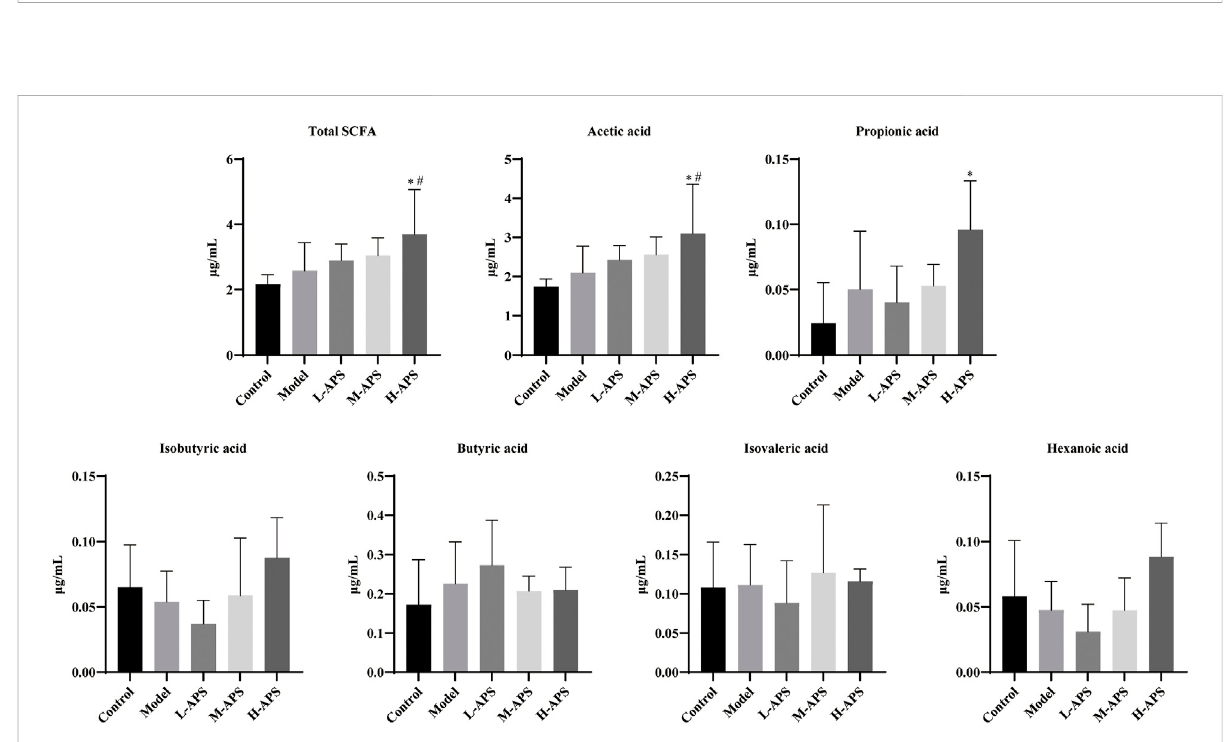
FIGURE 6 GC-MS detection of the effect of APS on the serum SCFA content. * p < 0.05 vs. control; # p < 0.05 vs. model.